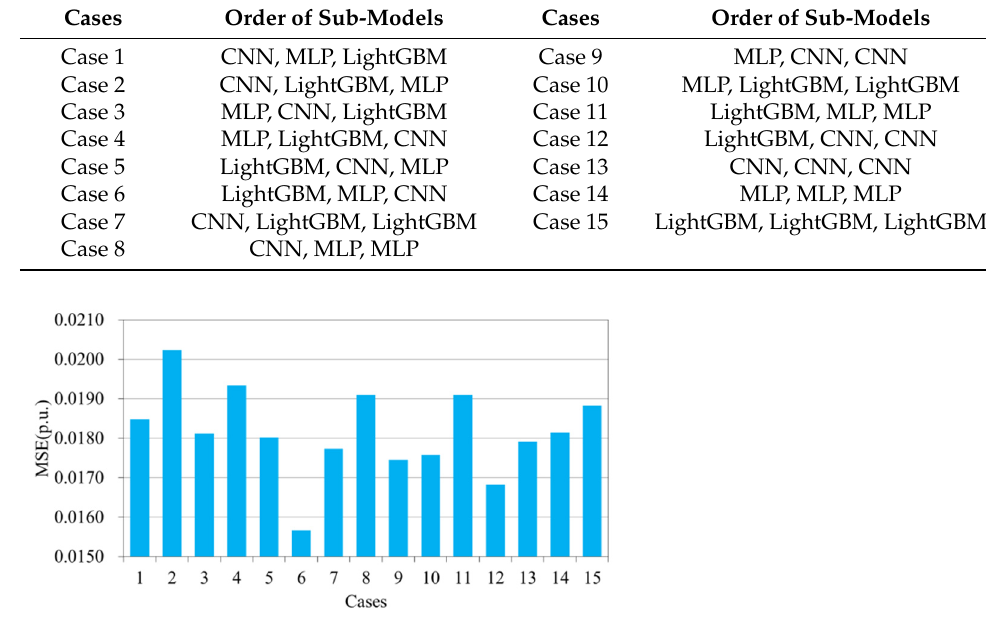
Figure 8. Results of ensemble models with different orders.